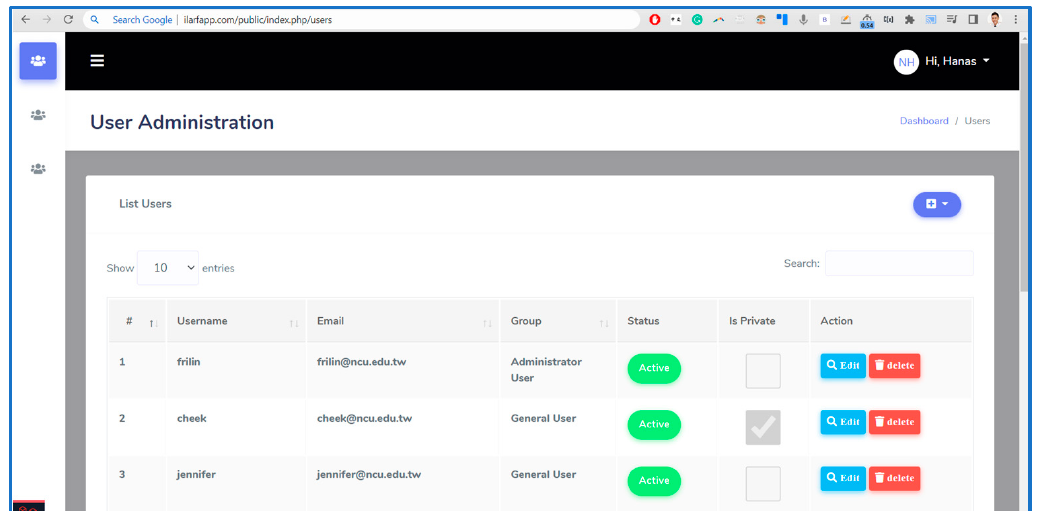
Figure 15. Screenshot of the ILARF server web interface.